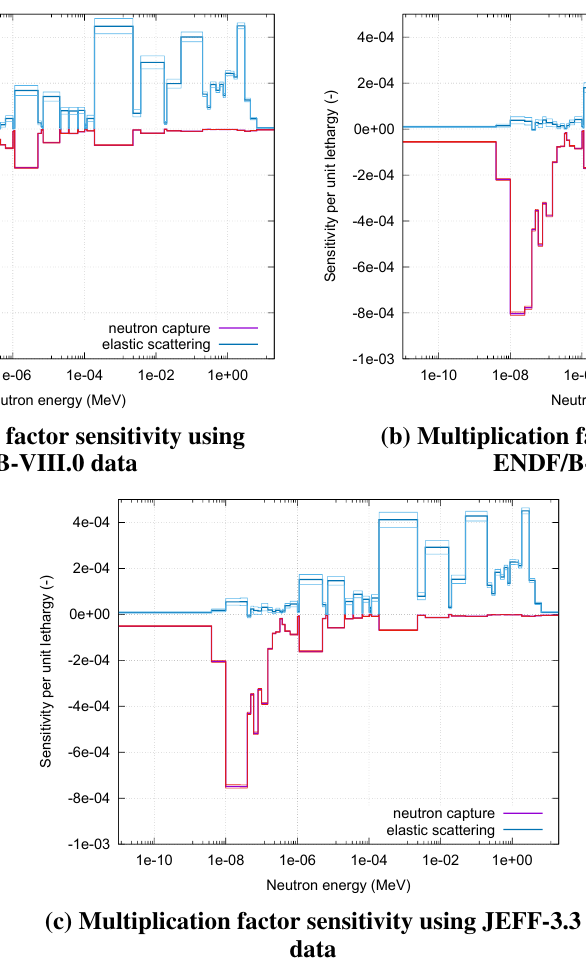
Figure 7: Multiplication factor sensitivity to stainless steel in reflector assemblies in 56group structure for various nuclear data in CX